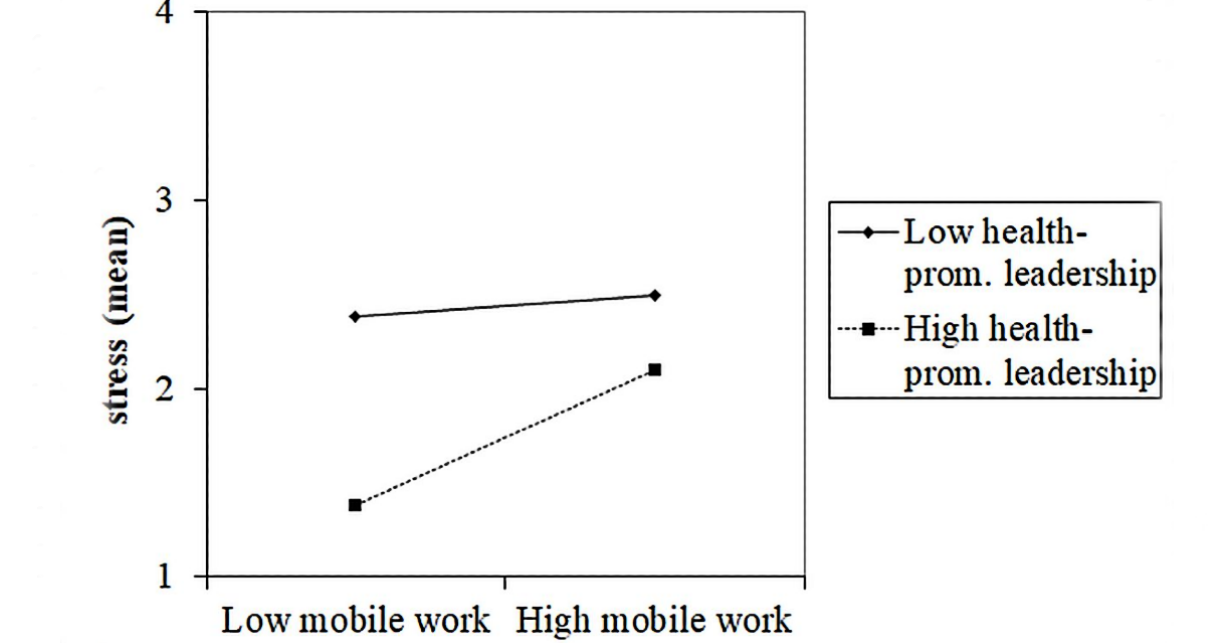
Figure 2. Effect of a two-way interaction between mobile work and health-promoting leadership on stress. prom.: promoting.